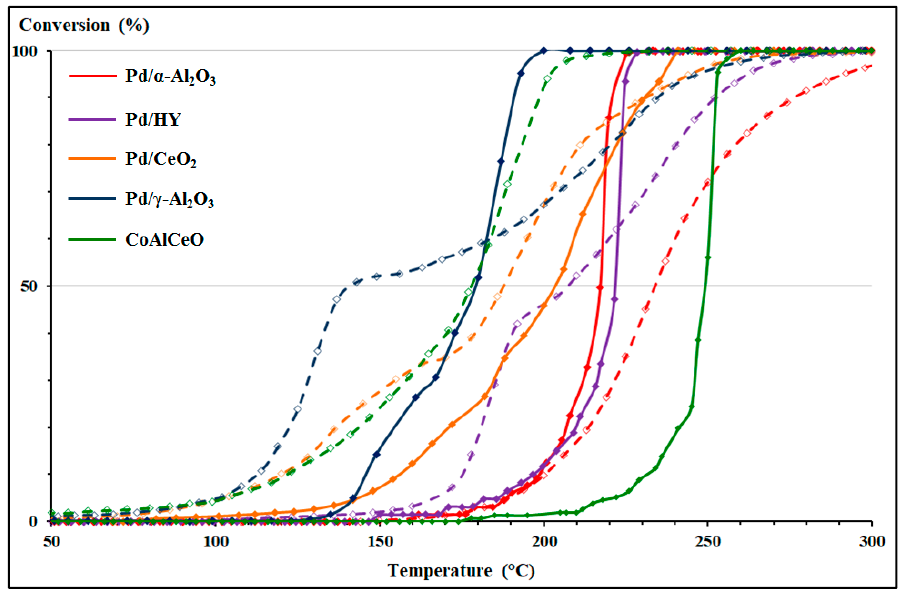
Figure 3. Comparison of light ‐ off curves for toluene (full lines) and MEK (dashed lines) total oxidation.